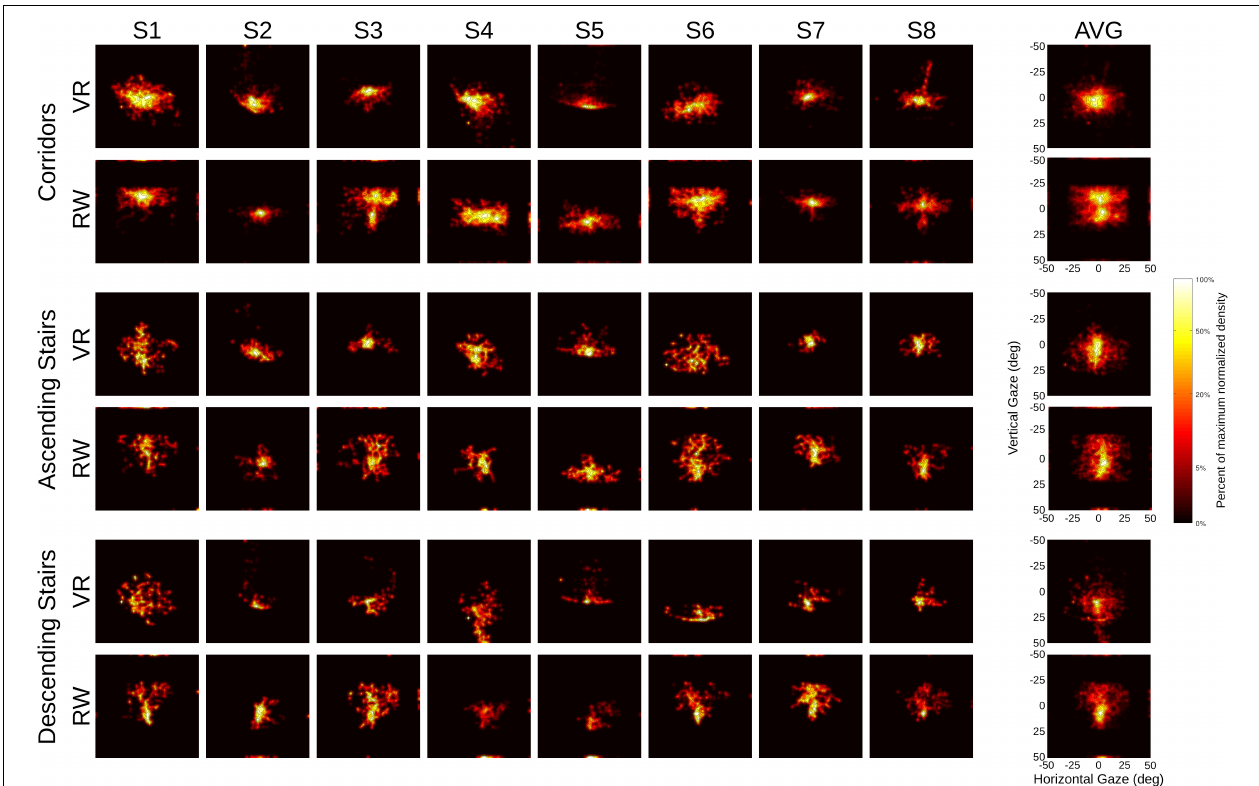
FIGURE 7 | Heat maps of gaze distribution, separated by world (virtual reality vs. real world) and sector type. Data normalized for each participant (S1 ... S8) and displayed with a logarithmic scale (with a slight regularization to accommodate zero values), see color bar. Average data across participants in column (AVG). Outer margin in each panel represents data points outside of the specified tracking area, squares span ± 50 ◦ in each